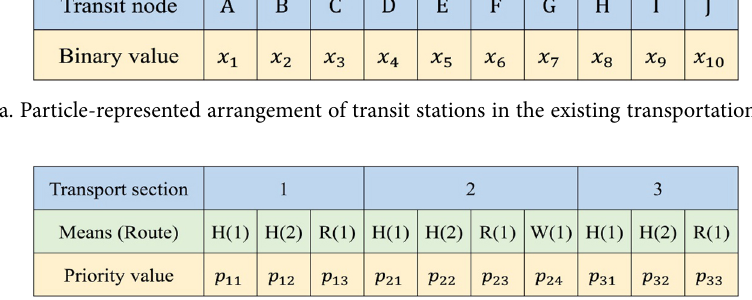
Figure 3b. Particle-represented selection of outsourcing producers, transit stations and transportation means and routes under